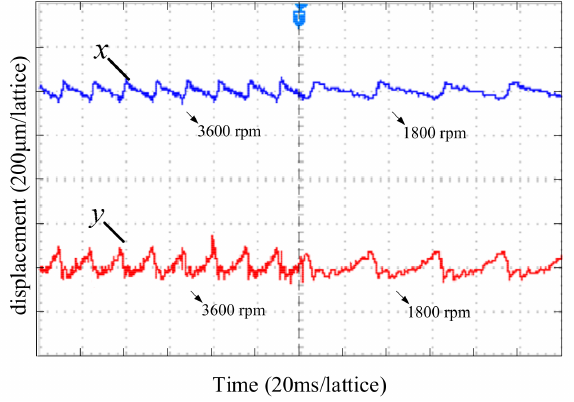
Figure 10. Rotor displacement at different speeds.